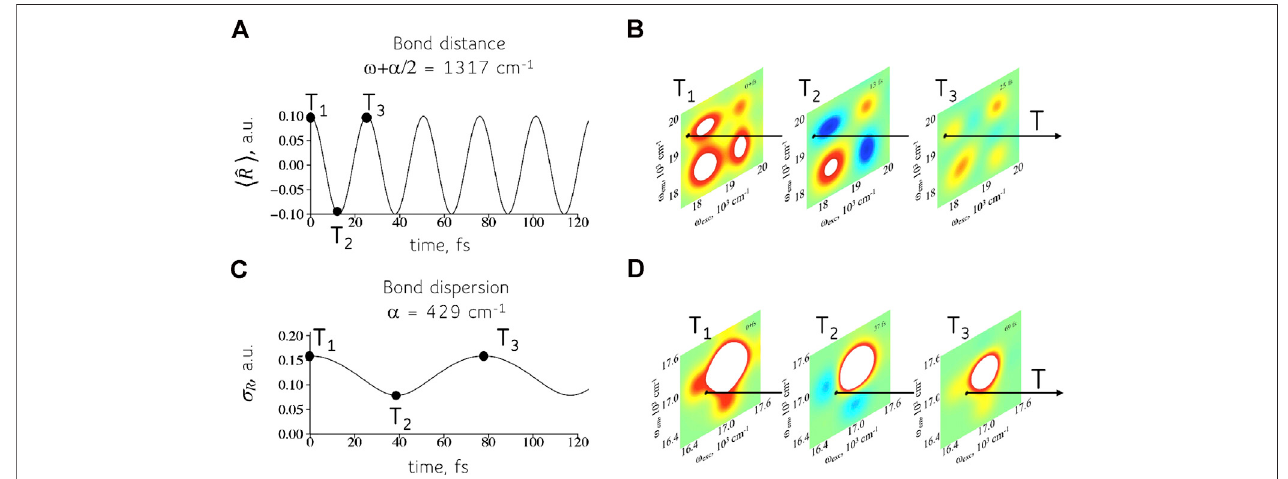
FIGURE3| Time-evolutionofthephysicalvariables (A,C) andtheircomputation (B,D) using2DfrequencymapsforthedeviceoftheQDdimers. Theresponseof the quantum device, panels (B) and (D) , can simulate the time dependent observables of the physical system such as the mean bond displacement, panel (A) , and the dispersion in the bond displacement, panel (C) . The physical system shown is a symmetric triatomic molecule. Shown are the real part of the 2D maps. See Supplementary Material, Section 1.2 , for details about the computation of the 2D maps.